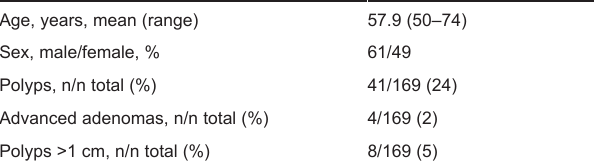
(Figure 1). The characteristics of the study population are summarized in Table